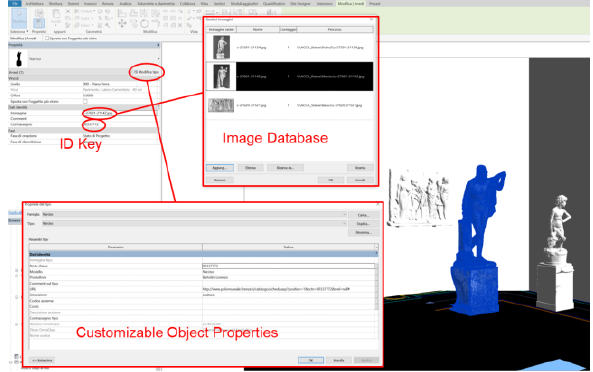
Figure 9. Artworks properties management test.